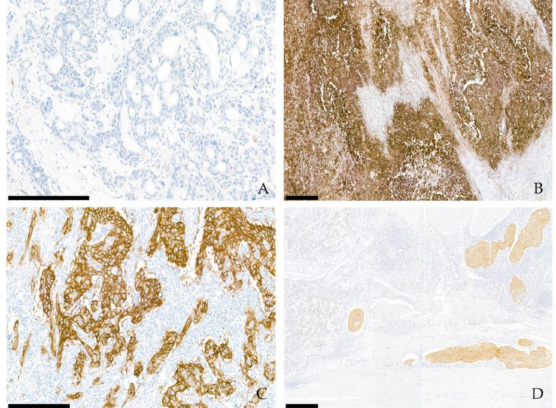
Figure 1. Representative microscopic findings of immunohistochemistry for PD-L1 ( A ) combined positive score 0; ( B ) combined positive score 90), for HER2 ( C ) with 3+ strong membranous staining in the tumor cells, and for FGFR2b ( D ) showing heterogeneous staining with positively stained tumor cells within lymphatic spaces. The scale length within the photograph is 300 µ